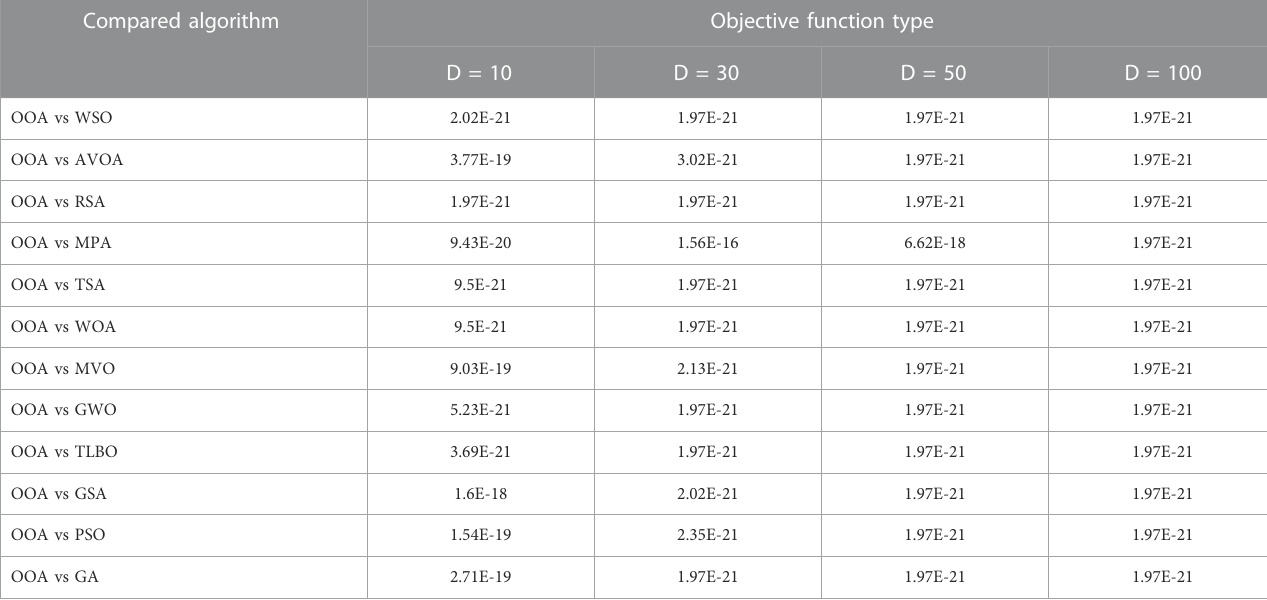
TABLE 6 p -values obtained from Wilcoxon rank sum test. Compared